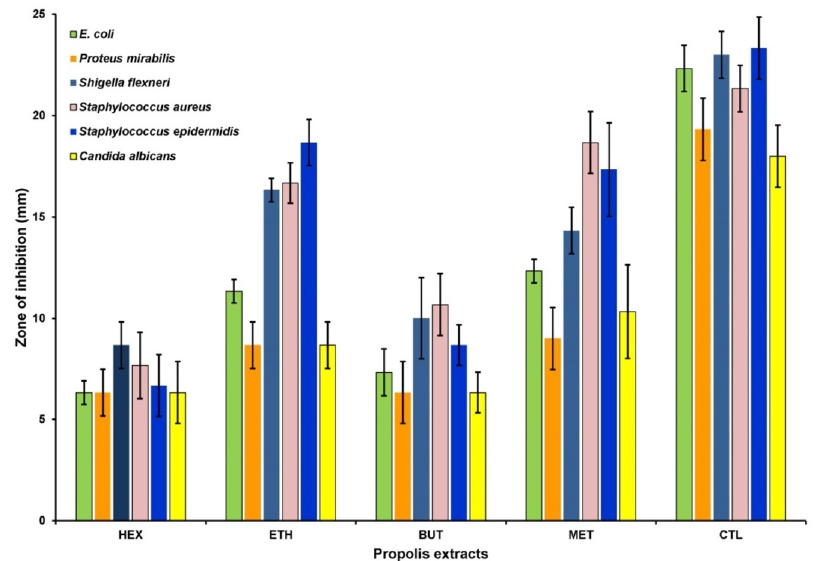
Figure 3. Antimicrobial capability of various propolis extracts (HEX = hexane, ETH = ethyl acetate, BUT = butanol, MET = methanol, and CTL = Control). ZOI is displayed as the average of 3 values. Error bars depict standard deviation (SD) of means.